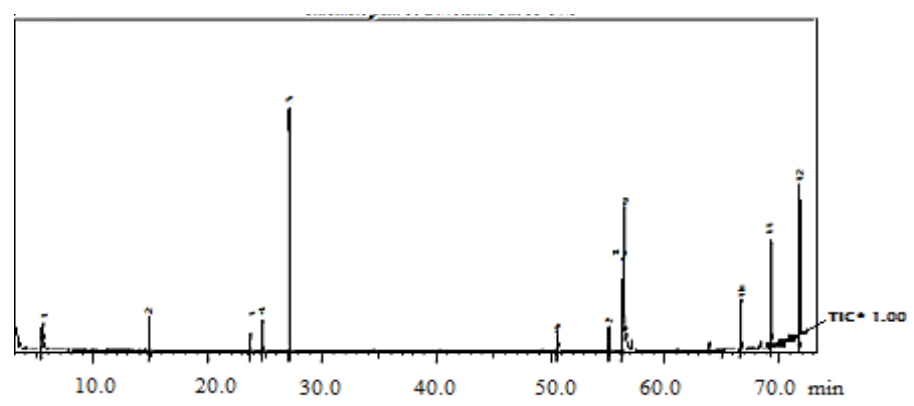
Figure 2. GC–MS chromatogram of M. spicata EO. Where (*) is the Total Ion Current. Table 1. The relative percentage of the area of peak of M. spicata EO constituents.